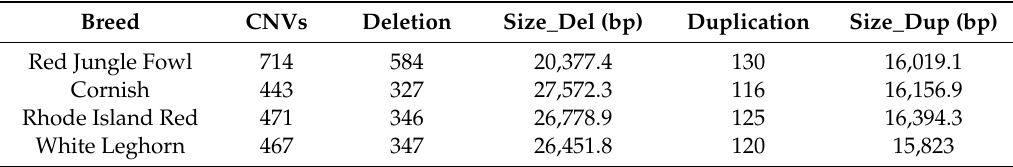
Table 1. Statistical summary of detected